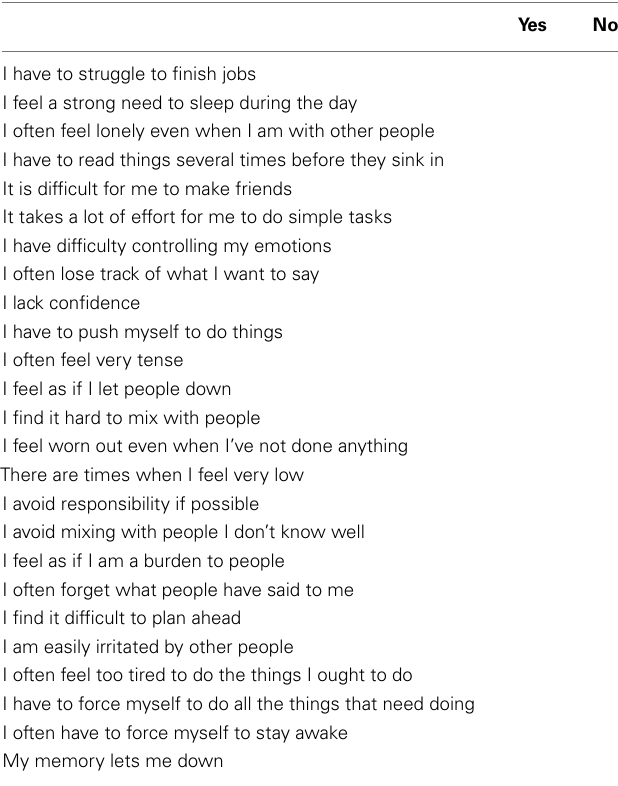
Table 2 |The syndrome of adult growth hormone deficiency (Cuneo et al., 1992; Carroll et al.,